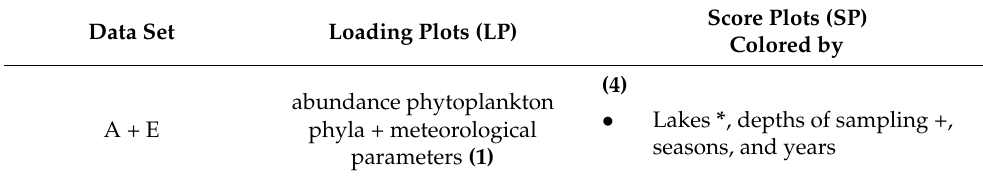
Table 4. Multivariate analysis plan to join dataset A and dataset E. Data